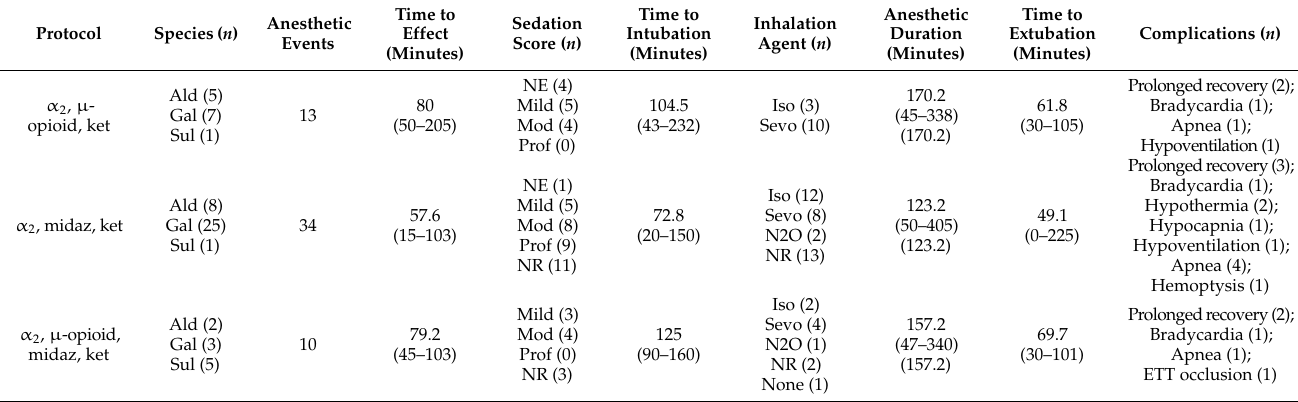
Table 2. Summary of data from the three most commonly used drug class combinations used for immobilizing Galapagos ( Chelonoidis nigra; Gal), Aldabra ( Aldabrachelys gigantea, Ald), and African spurred tortoises ( Centrochelys sulcata; Sul). The three most common drug class combinations were an α 2 -adrenergic agonist combined with a µ -opioid and ketamine, an α α µ -opioid, 2 -adrenergic agonist combined with midazolam and ketamine, and an 2 -adrenergic agonist combined with a midazolam, and ketamine. Sedation scores were subjectively determined by the individual anesthetist rather than a structured sedation scoring system. Data for time is reported as mean (range). α 2 , α 2 -agonist; Iso, isoflurane; Ket, ketamine; Midaz, midazolam; Mod, moderate sedation; NE, no sedative effect; N 2 O, nitrous oxide; NR, not reported; Prof, profound sedation; Sevo,